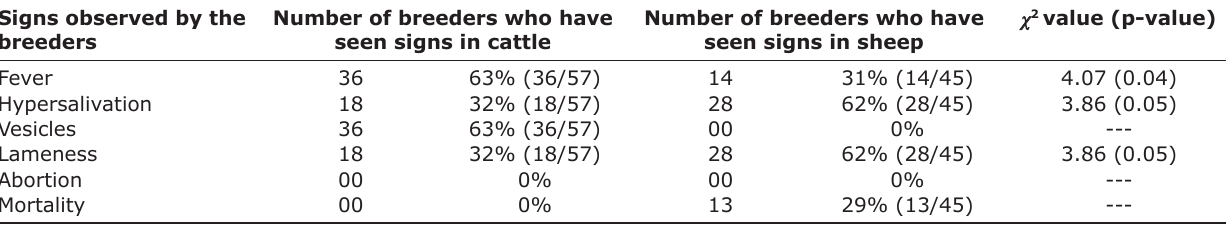
χ 2 value (p-value)